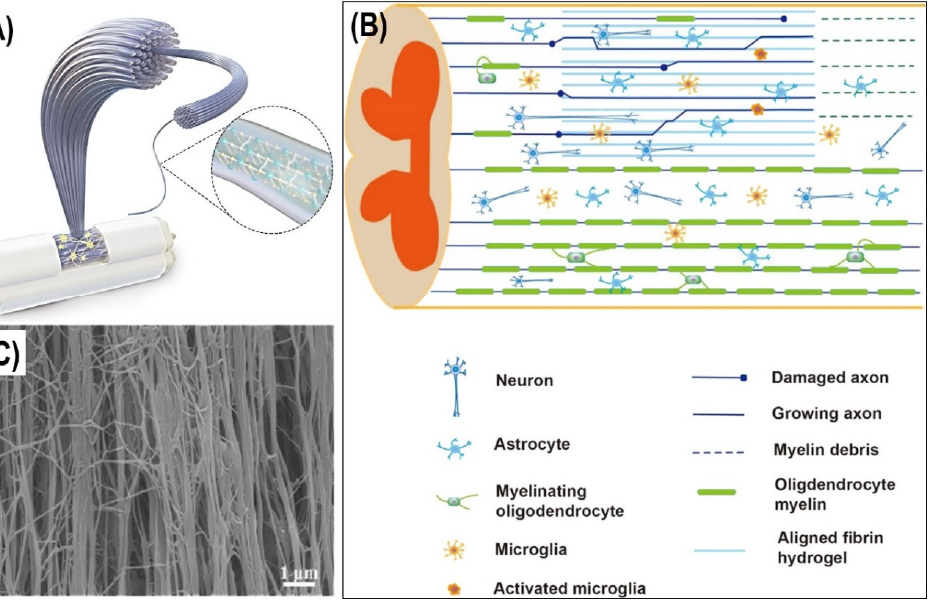
Figure 7. ( A ) Surgery process of canine traumatic hemisection T12 SCI model. ( A ) Diagram of AFG and ( B ) the SCI surgery and AFG transplantation process. Reprinted/adapted with permission from Ref. [53]. 2022, Oxford University Press. ( B ) Schematic diagram of the axonal regrowth across the lesion site along the aligned nanofibers. Reproduced with permission from [52]. ( C ) Photomicro- graph of electrospinning aligned fibrin hydrogel. Reprinted/adapted with permission from Ref. [54]. 2020, Springer Nature.